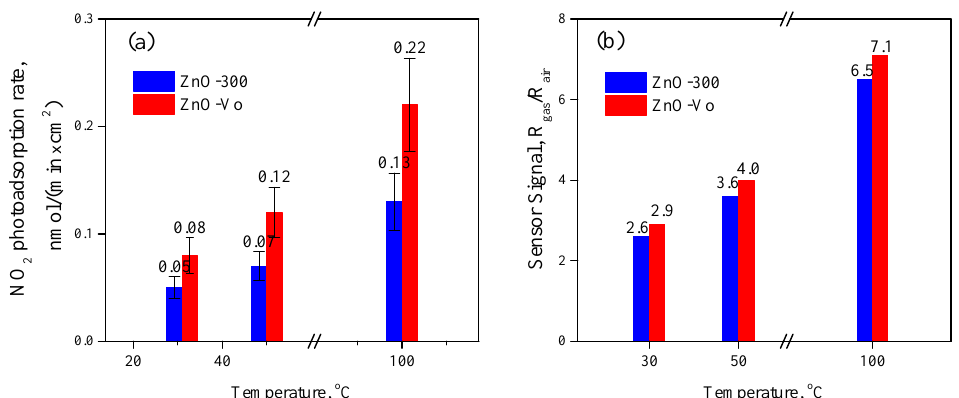
Figure 15. ( a ) Diagram shows the photoadsorption rate of NO 2 from an oxygen-rich atmosphere on ZnO-300 and ZnO-V O samples at different temperatures (data extracted from graphs in Figure 9); ( b ) diagram shows sensor response of ZnO-300 and ZnO-V O samples to 3.8 ppm NO 2 at different temperatures (data extracted from graphs in Figure